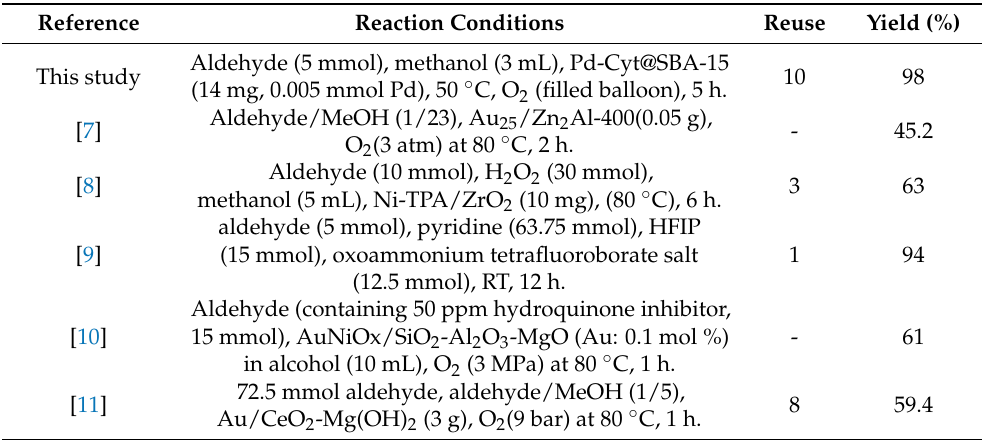
Table 3. Comparison of catalytic activities in aerobic oxidation of benzaldehyde using heteroge- neous